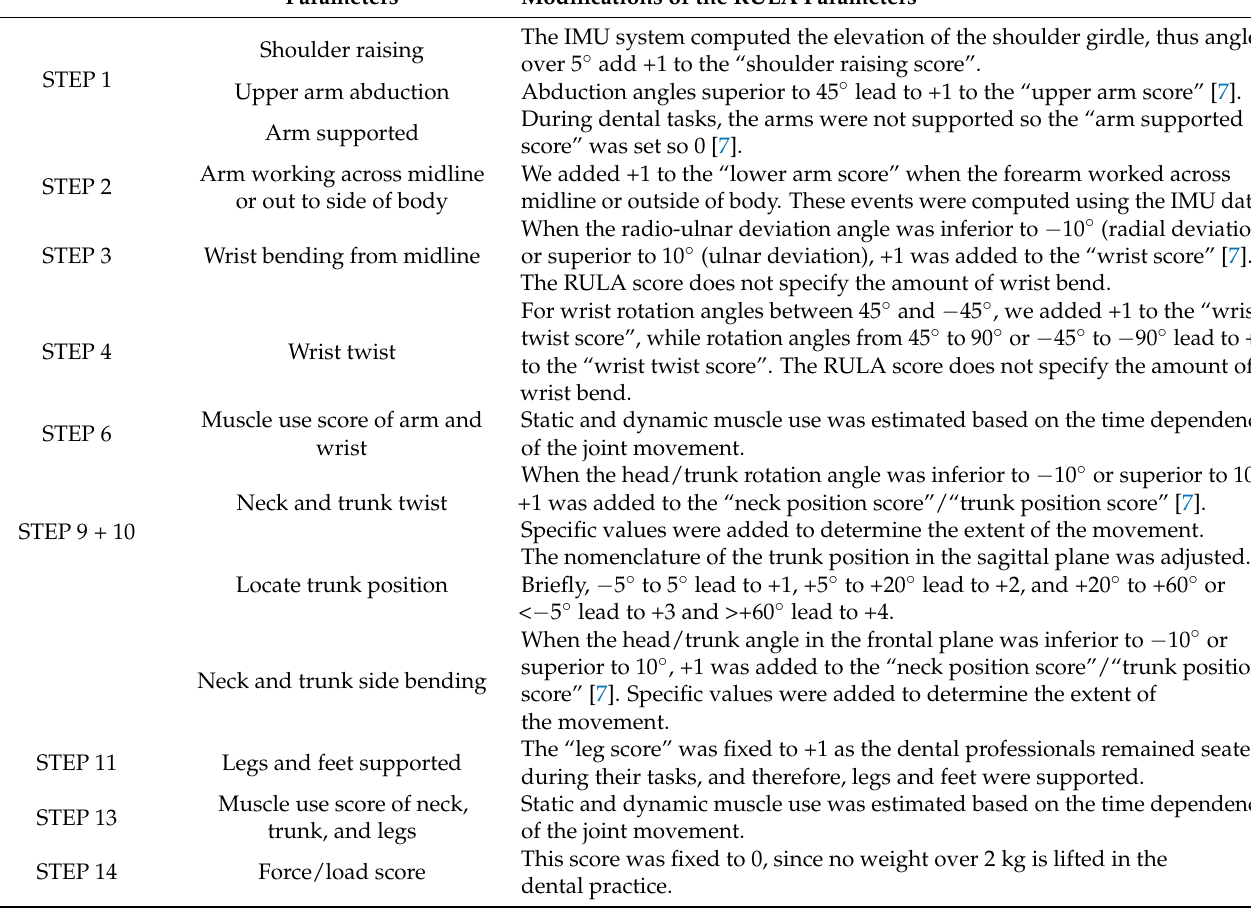
Table 1. RULA modifications. This table sums up the modifications to several original RULA steps that were applied in order to quantify and automate qualified thresholds.